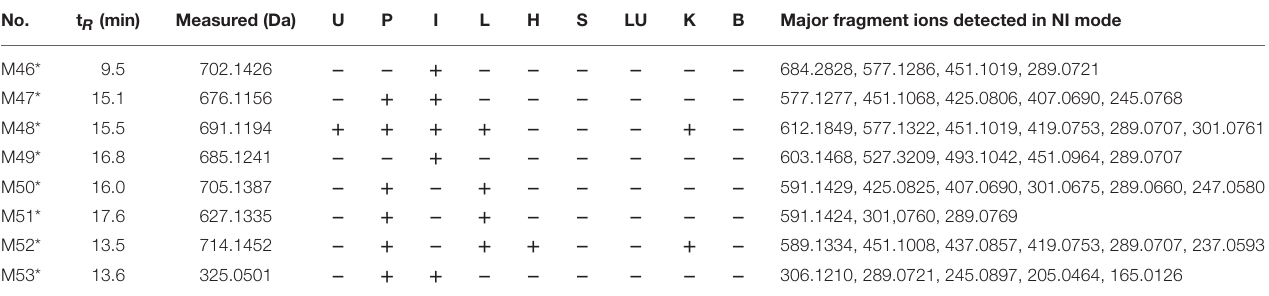
TABLE 2 | MS n data obtained in negative ion detection mode of 8 unidentified metabolites in urine, plasma, and organ distributions of mice. No.